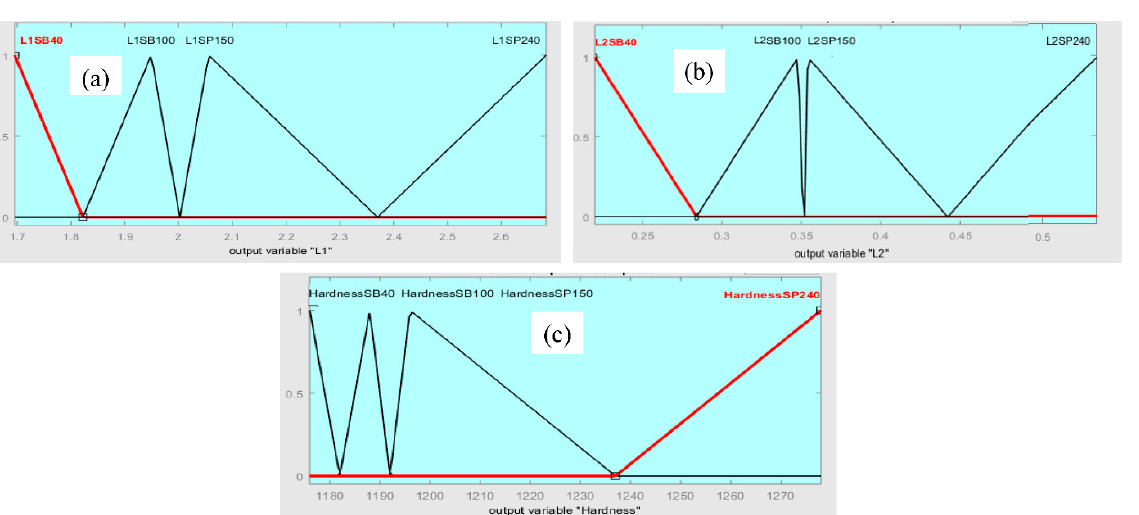
Table 4. Membership functions of fuzzy system outputs.